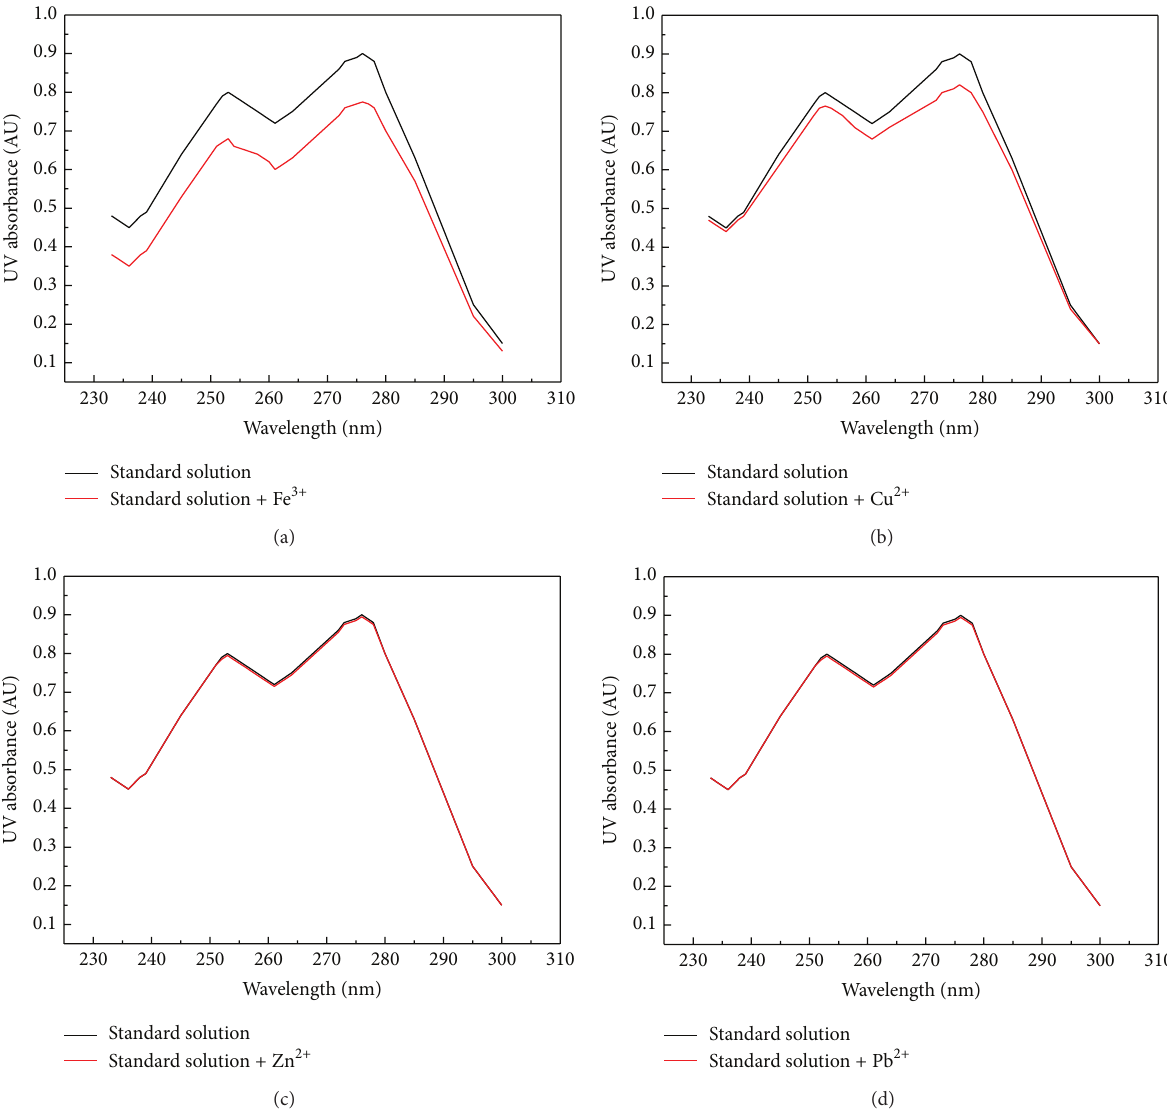
Figure 5: Ultraviolet spectrum of NND and NND + M n + M n + = Fe 3+ , Cu 2+ , Zn 2+ , Pb 2+ .